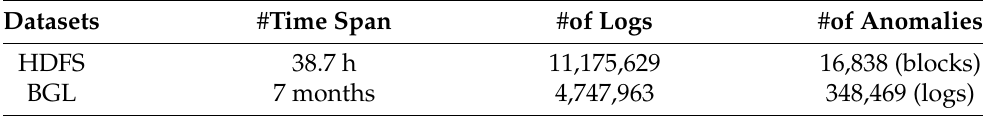
Table 2. Summary of log